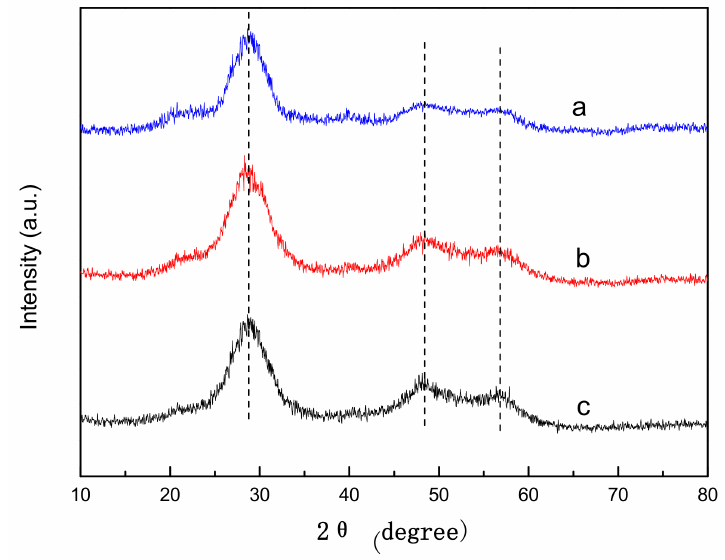
Figure 1. XRD patterns of ZnS-GQDs (a), ZnS-graphene (b) and pure ZnS